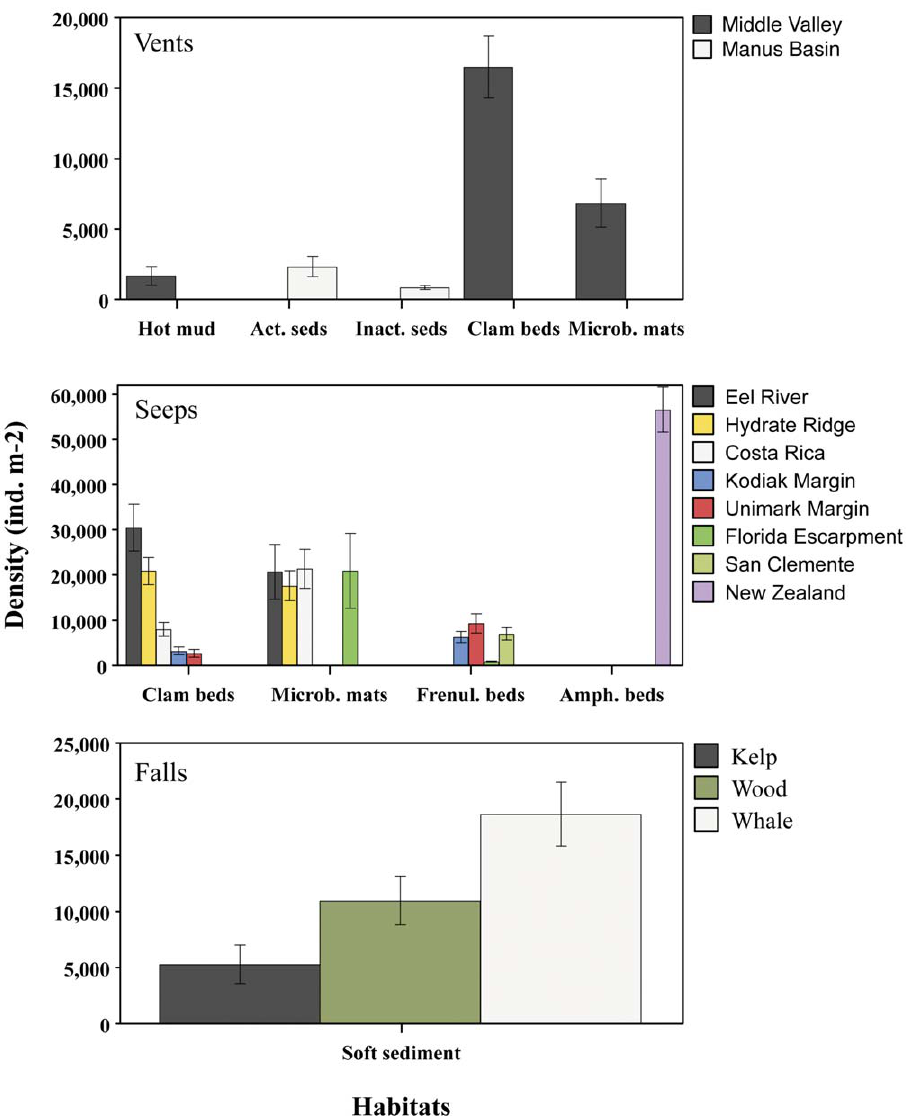
Figure 2. Macrofaunal density per habitat across Vents (upper panel), Seeps (middle panel), and Organic-Fall (lower panel) ecosystems. Average values ( 6 1